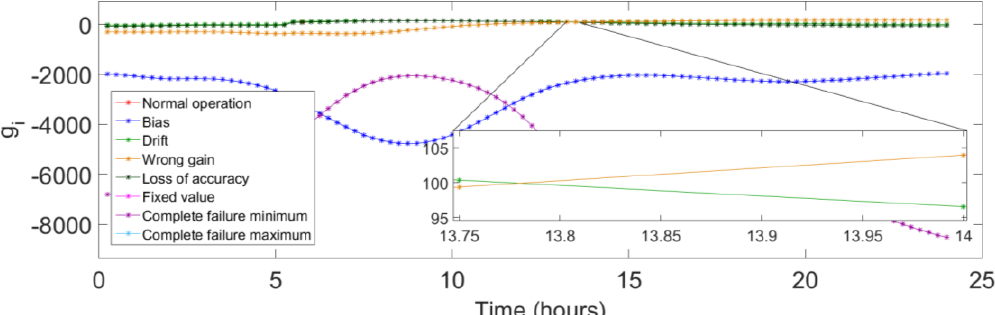
Figure 5. Wrong gain diagnosis: graphs of the FDA discriminant functions gi(x) for each of the normal and seven fault classes, along the 24 h of the 140th day and the detailed representation revealing the class of the observations and the time moment of the firm fault type identification.